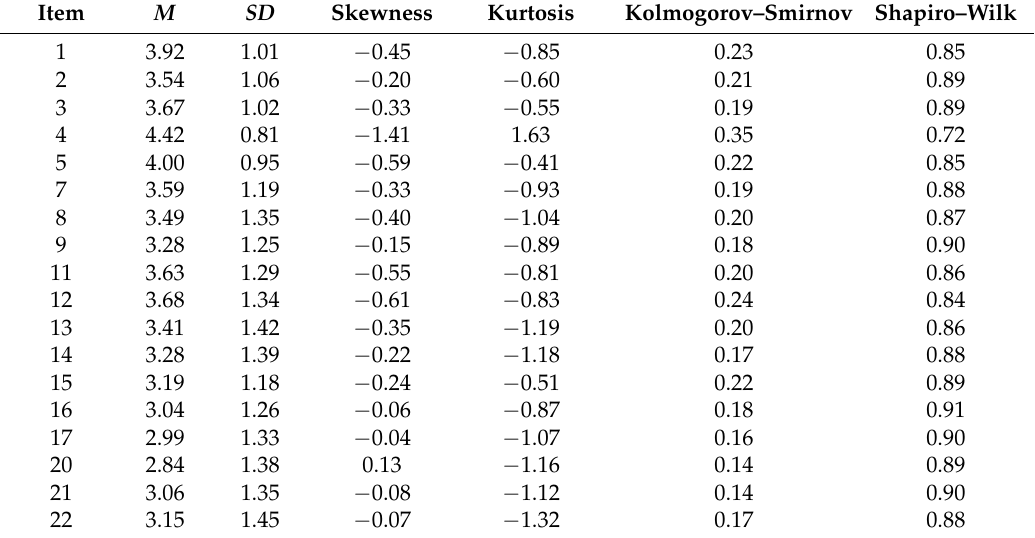
Table 2. Descriptive and distribution statistics of the items in the final version of the instrument.